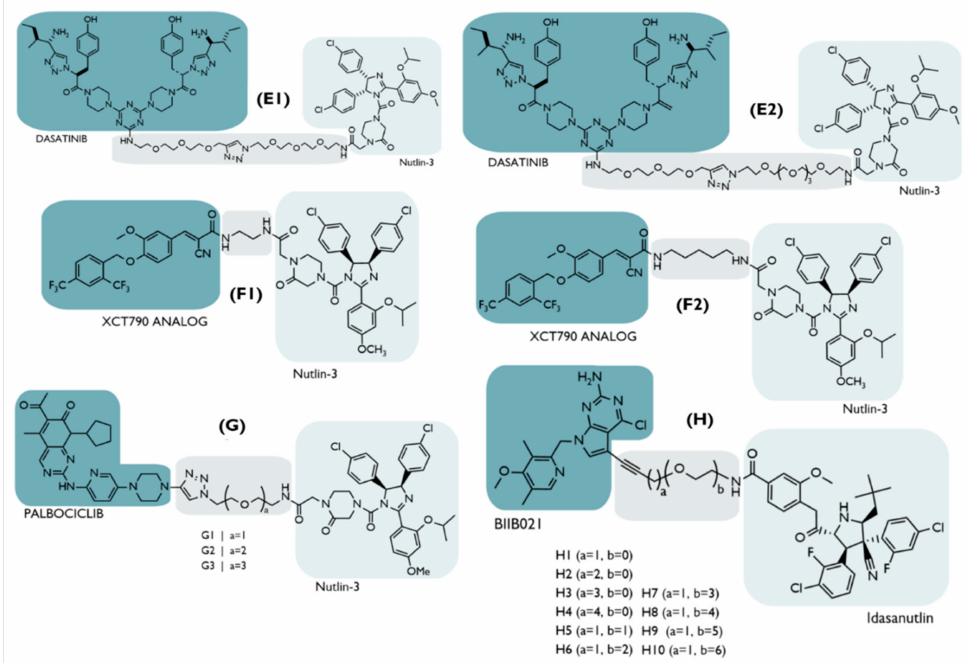
Figure 10. Chemical structure of some MDM2-based PROTACs intended for the treatment of breast cancer. The PROTACs E1 and E2 target the tropomyosin receptor kinase C (TrkC) [69]; the F1 and F2 PROTACs target the estrogen-related receptor α (ERR α ) [70]; PROTACs G, with diverse types of linkers, degrade cyclin-dependent kinase 6 (CDK6) [71]; PROTACs H degrade heat shock protein 90 (HSP90)